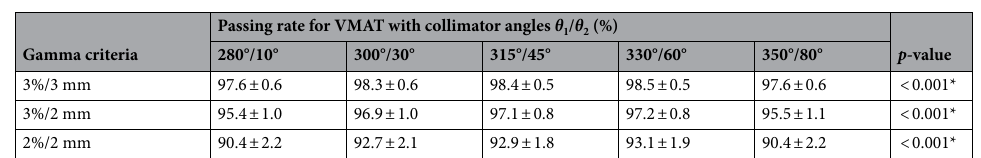
Table 4. Passing rates of Δ θ = 90° plans using 3%/3, 3%/2, and 2%/2 mm gamma criteria, along with their Friedman test results. *Statistically significant ( p < 0.05).